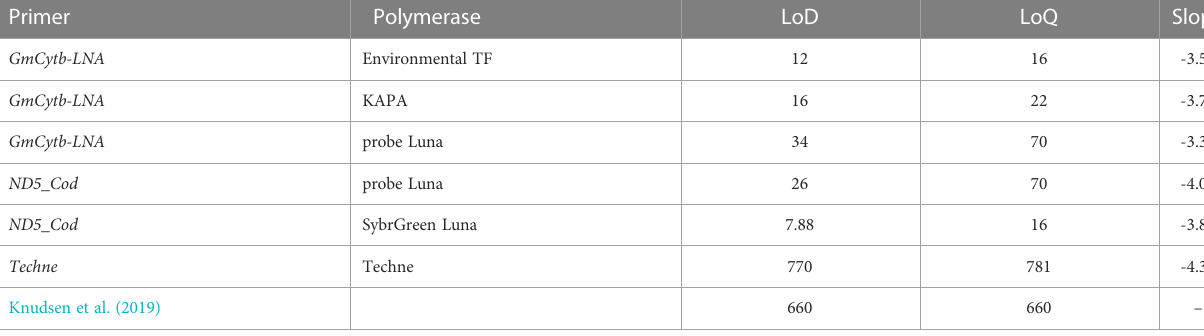
TABLE 3 Comparison of polymerase performance based on LoD and LoQ